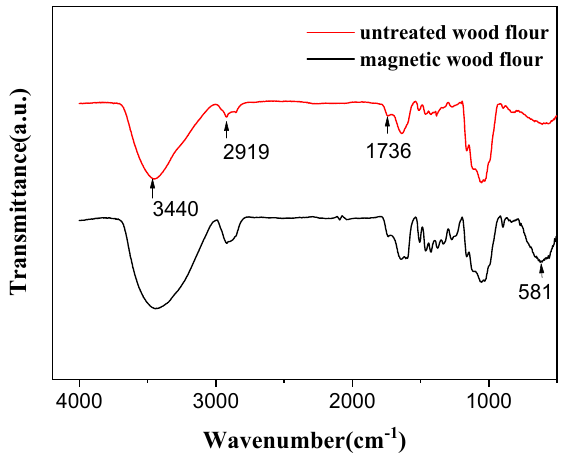
Figure 3. FTIR curves of the pure wood flour and the magnetic wood flour.